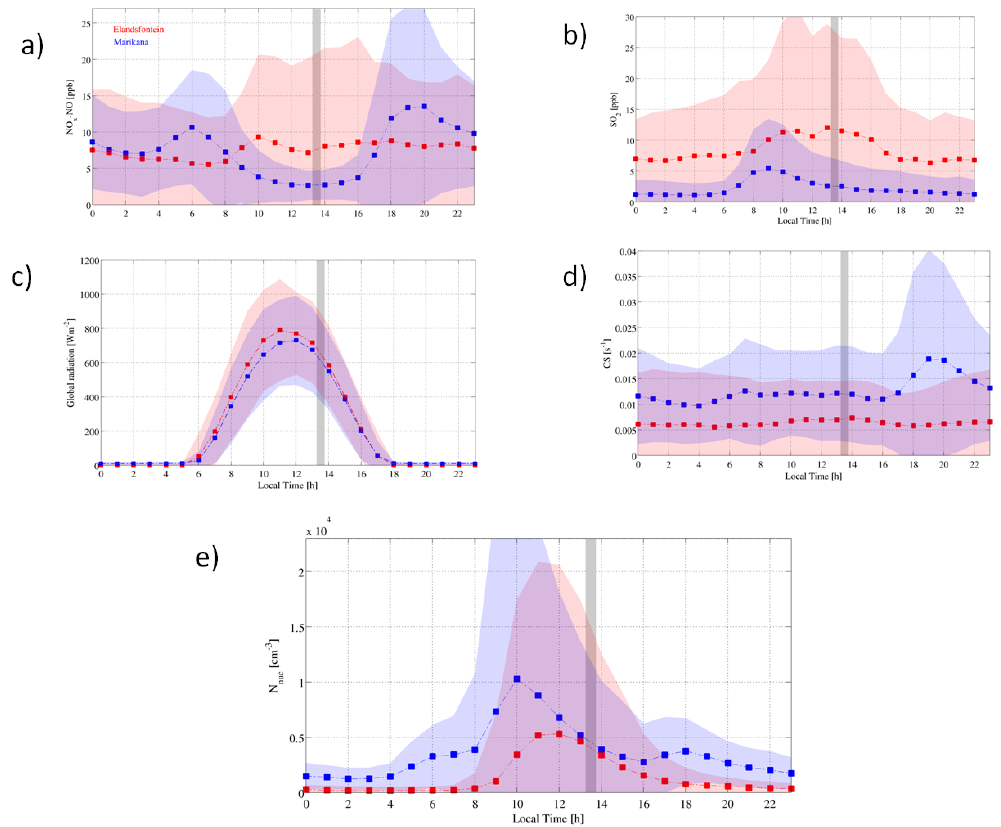
Figure 7. Diurnal variation of (a) NO x -NO, (b) SO 2 , (c) global radiation, (d) CS, and (e) N nuc at Elandsfontein (red) and Marikana (blue) stations. The grey columns represent the time window for the satellite overpass. The blue and red shading denote the 75th and 25th percentiles. It is noted that CS at Elandsfontein is defined with particles D p < 10µm and at Marikana with particles D p < 1µm. N nuc at Marikana represents particles D p < 30nm while at Elandsfontein N nuc represents particles D p